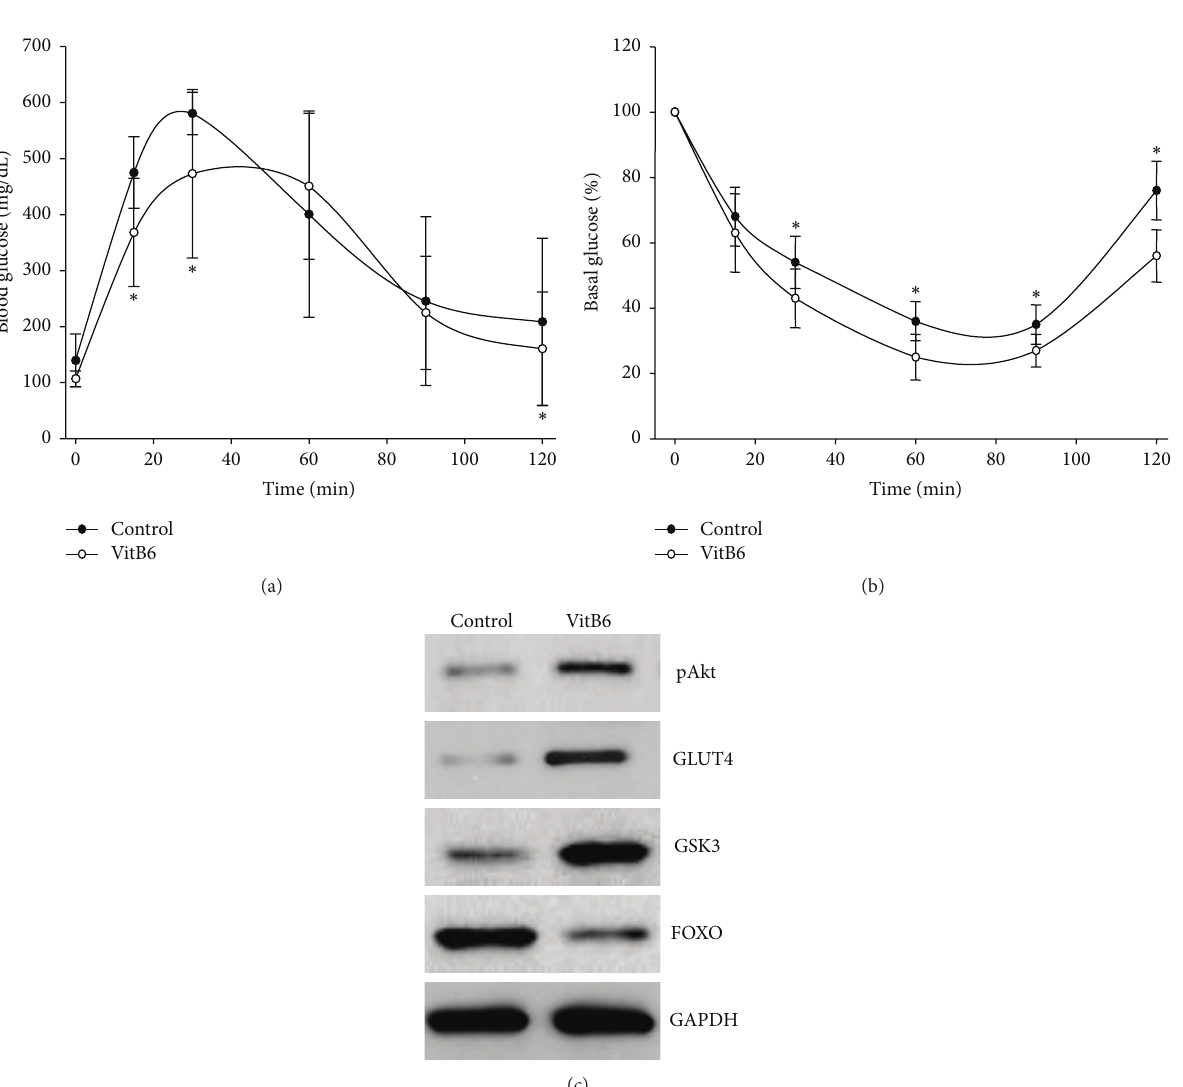
Figure 2: VitB6 improves insulin resistance in 𝐴𝑝𝑜𝑒 −/− mice fed with high-fat diet. Male 𝐴𝑝𝑜𝑒 −/− mice at the age of 6 weeks received high-fat diet and VitB6 (50 mg/kg/day) administration in drinking water. At the 8th weekend after VitB6 treatment, (a) GTT and (b) ITT were evaluated as described in Section 2. All data were expressed as mean ± SEM. 𝑁 is 10–15 in each group. ∗ 𝑃 < 0.05 versus control. (c) Homogenates of liver tissues were subjected to perform western blotting analysis to assay the levels of pAKt, GLUT4, GSK3, and FOXO. The picture is a representative blot from 10–15